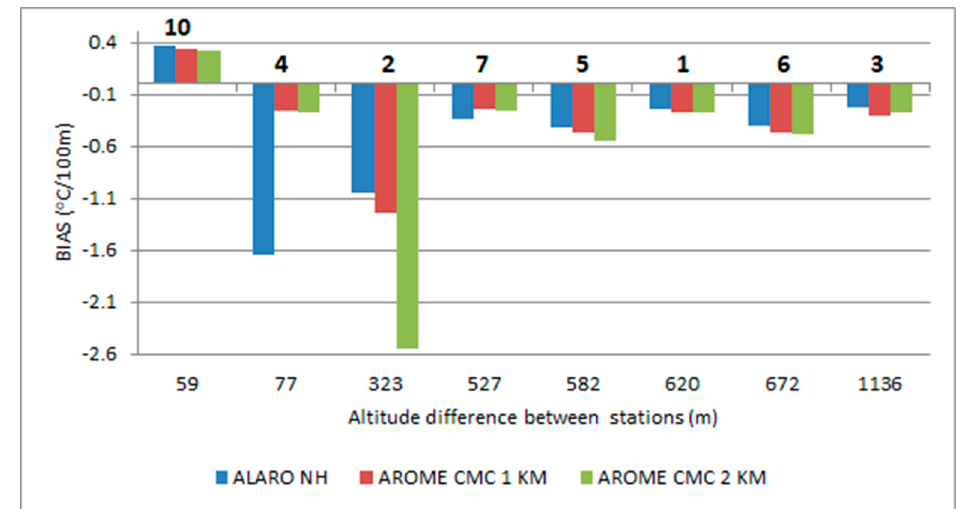
Figure 16. Bias values for predicted temperature gradients for two kilometric scale resolution models (AROME CMC 1 km and ALARO NH) and operational AROME CMC 2 km as reference.